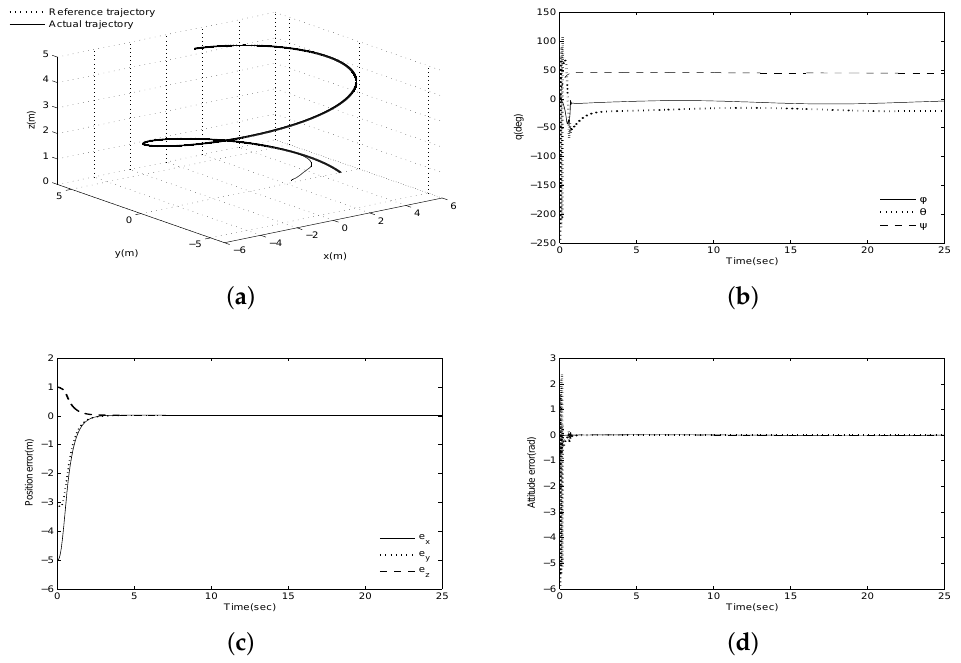
Figure 3. Tracking results of the robust backstepping sliding mode control (RB-SMC) method: ( a ) Three-dimensional trajectory; ( b ) Euler angles q ; ( c ) Position tracking errors; ( d ) Attitude tracking errors.